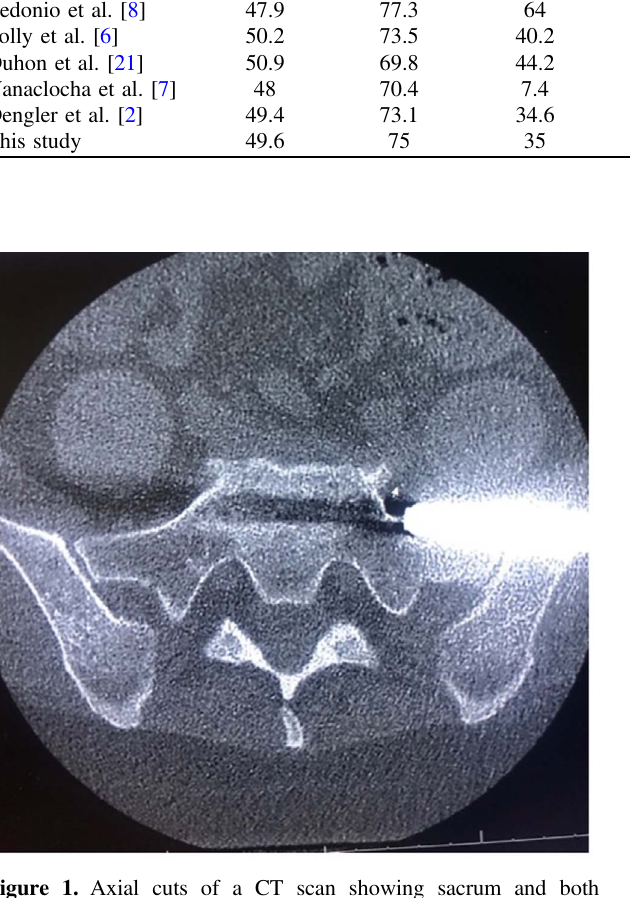
Figure 1. Axial cuts of a CT scan showing sacrum and both sacroiliac joints, note the implant breaches the left sacroiliac corridor anteriorly.